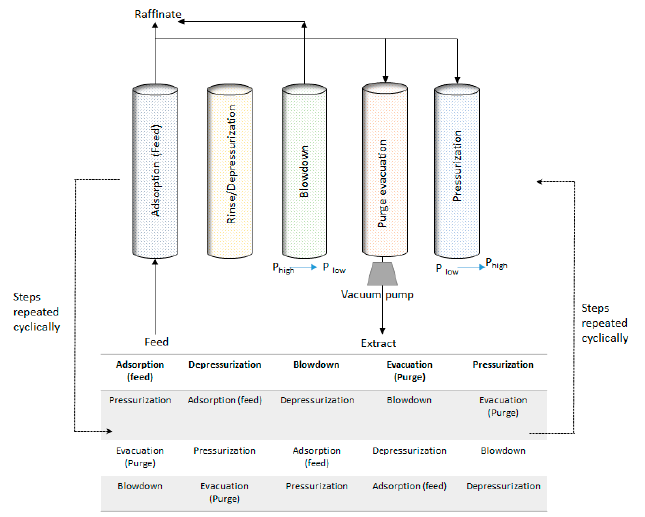
Figure 2. Schematic showing the fixed bed column (Vacuum Pump—Rocker Scientific, New Taipei City, Taiwan, China; Pressure control valve—SS-43GXS4 Swagelok, Solon, Ohio, USA; Mass Flow